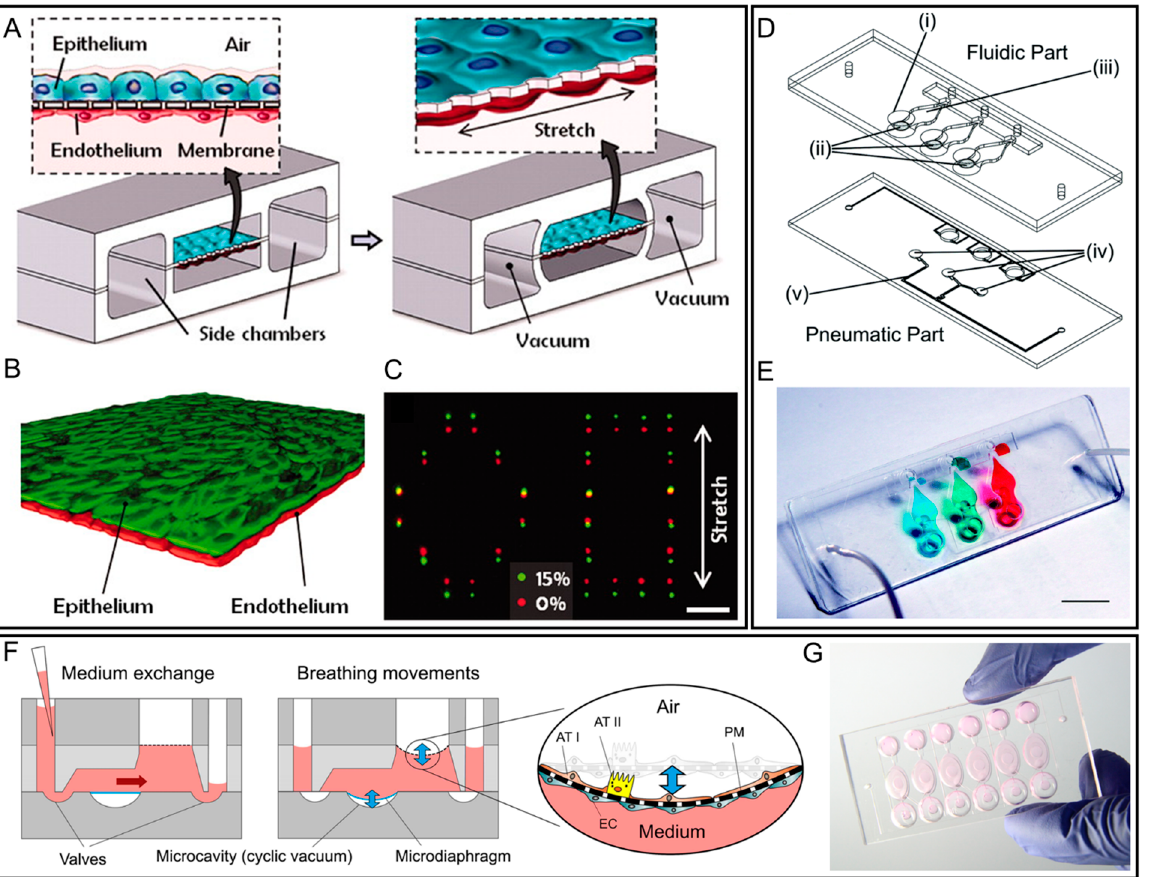
Figure 3. Lung-on-a-chip platforms with microfluidic actuators. ( A ) Schematic of reconstituted dynamic human lung-on-a-chip system. To mimic the similar in vivo alveolar–capillary microenvironment, air and fluid are introduced to the upper and lower microchannels isolated by a porous PDMS membrane. The membrane is sealed by monolayers of alveolar epithelial and microvascular endothelial cells. Reproduced with permission from [61]. ( B ) Long-term microfluidic coculture produces a tissue–tissue interface consisting of a single layer of the alveolar epithelium (Green) closely opposed to a monolayer of the microvascular endothelium (Red). ( C ) Membrane stretching-induced mechanical strain visualised by the displacements of fluorescent quantum dots. ( D ) Schematic and ( E ) actual image of a lung-on-a-chip system that is composed of a fluidic part and pneumatic parts. Primary human pulmonary alveolar epithelial cells are seeded onto the sandwiched PDMS membrane in the fluidic part, and the pressure from the micro-diaphragm beneath can be transmitted through the chamber with incompressible medium to the membrane. Reproduced with permission from [63]. ( F ) Schematic cross-sections of the alveolus-on-chip platform with two operation modes: Breathing and medium exchange modes. The breathing motions of the alveolar barrier are induced by a microdiaphragm when applying a cyclic vacuum to the microcavity. Hydrostatic and surface tension forces transport the flow. ( G ) Photograph of the chip with six independent alveolar barrier systems filled with cell culture medium. Reproduced with permission from